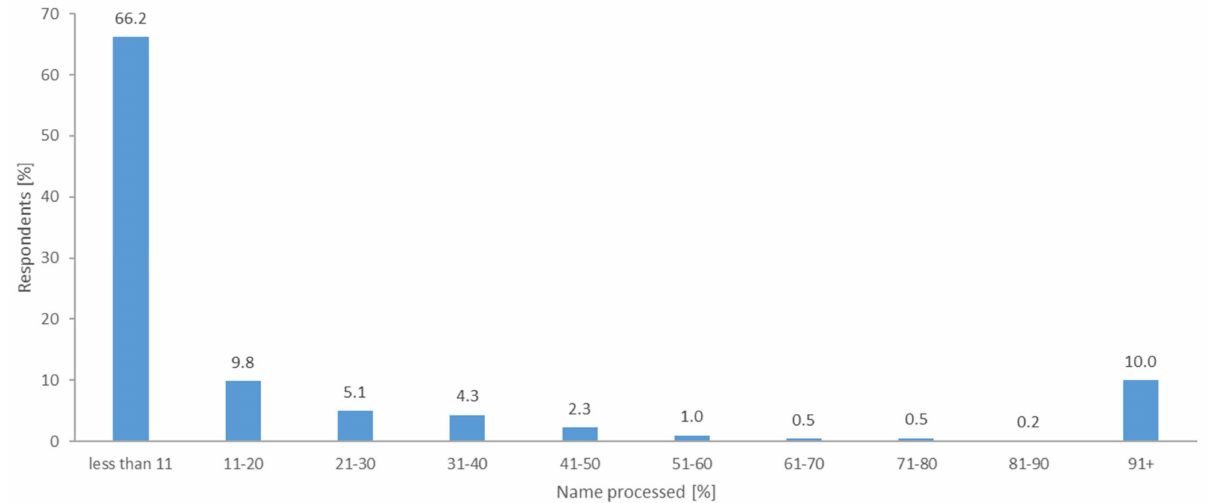
Figure 7. The degree of involvement of the respondents in the project. Only respondents who commented on at least one name are included (number of respondents = 927, number of names =